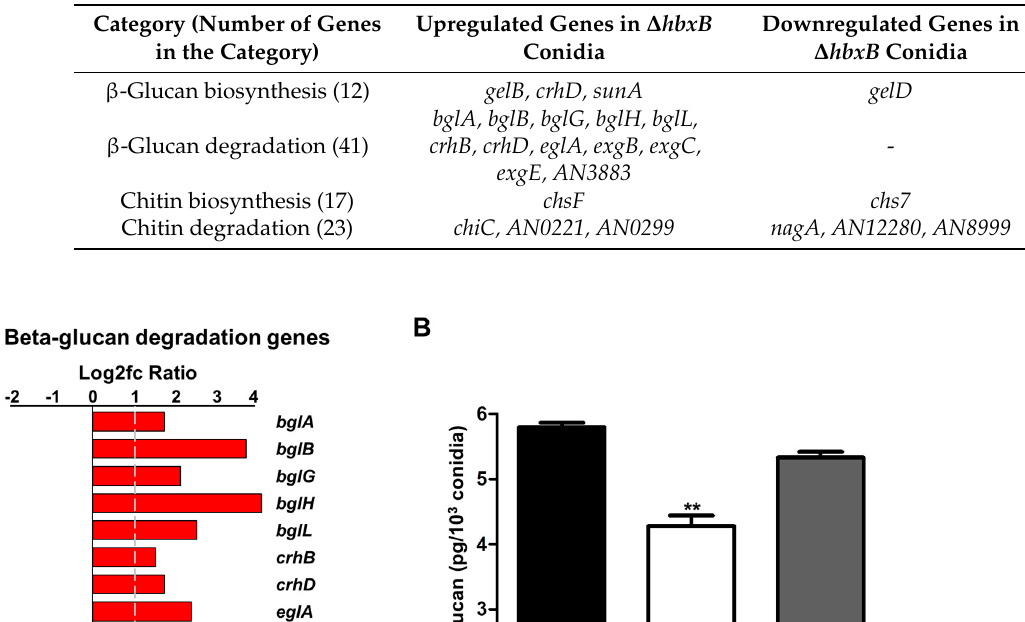
Table 1. Differentially expressed genes (DEGs) associated with cell wall integrity in Δ hbxB conidia.